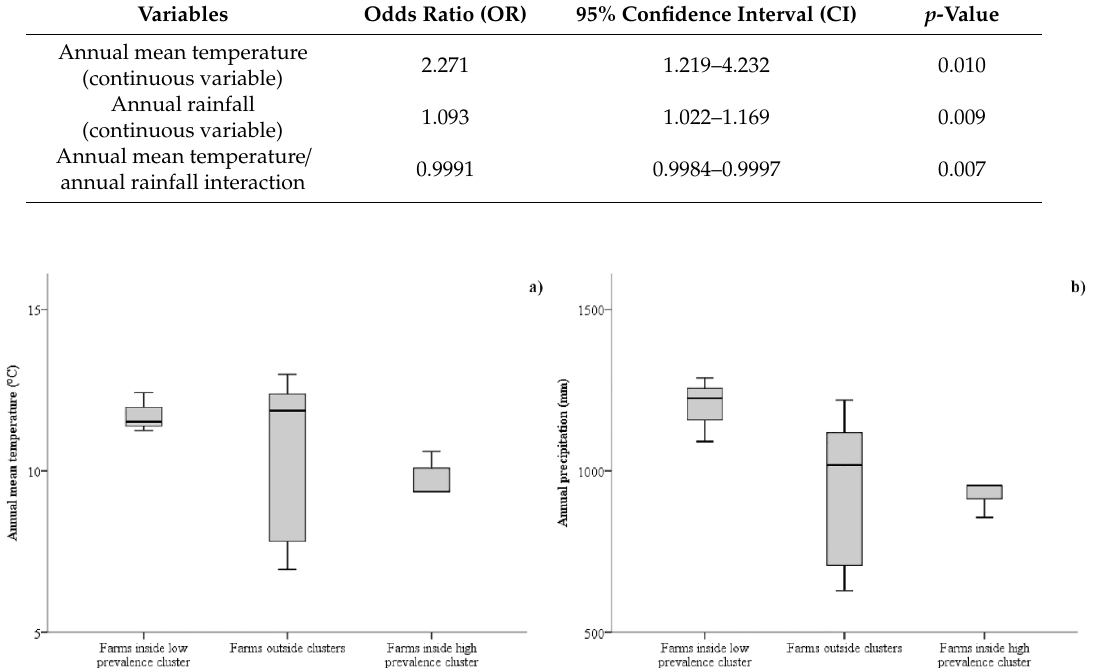
Figure 5. Annual mean temperature ( a ) and annual rainfall ( b ) in sheep farms sited inside the low T. gondii prevalence cluster, outside clusters, and inside the high T. gondii prevalence cluster. Table 2. Risk factors associated with higher Toxoplasma gondii prevalence in sheep farms using multivariate multilevel modeling.